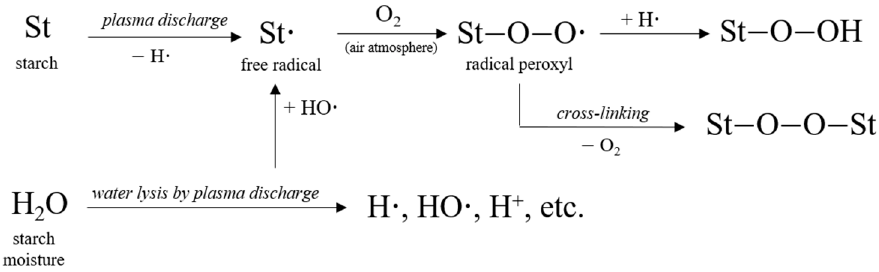
Figure 3. Cross-linking mechanism for plasma-processed starch.